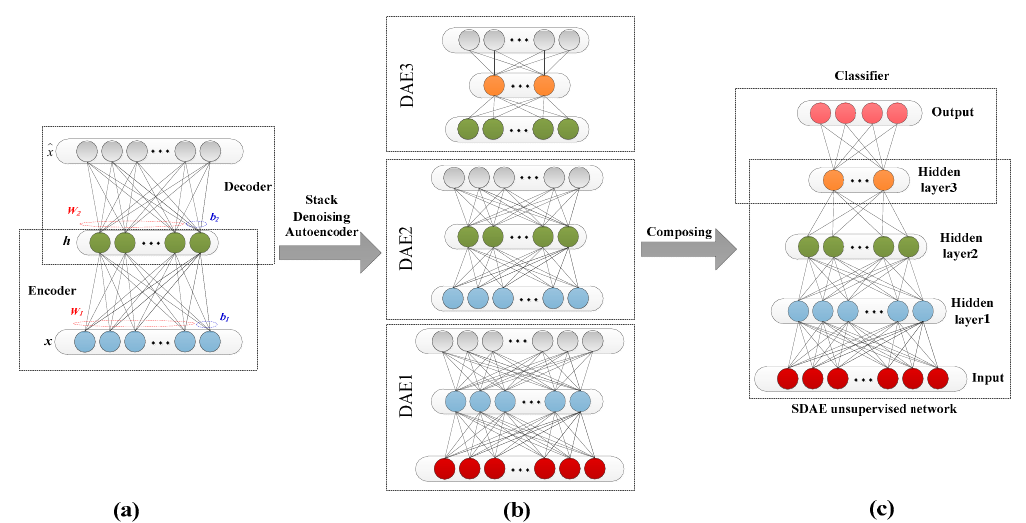
Figure 2. ( a ) Structure of DAE; ( b ) structure of the SDAE; ( c ) supervised for classification.